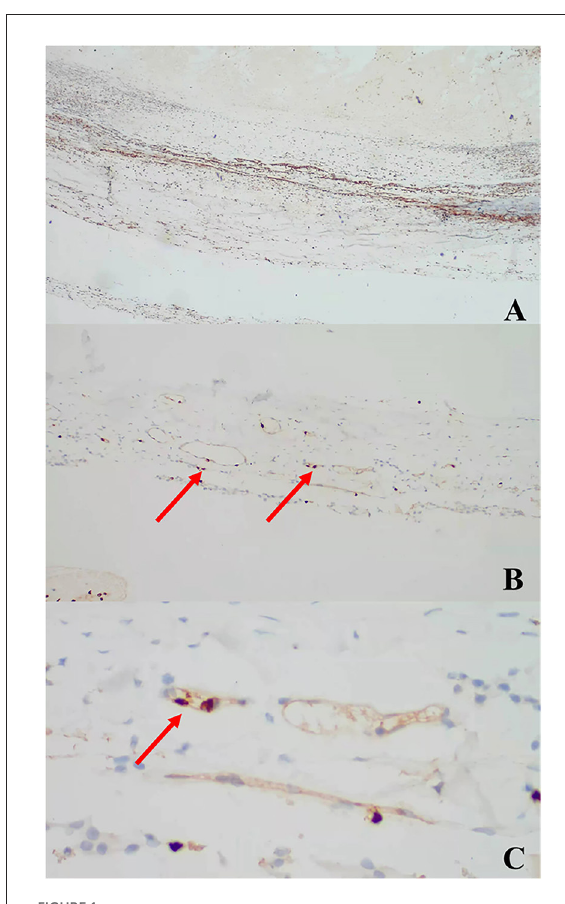
FIGURE1 Anti-MMP-8 antibody immunostaining: (A) × 40, (B) × 100, (C) × 400 (arrows).